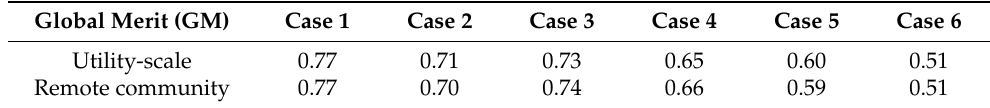
Table 11. Qualitative assessment of wave energy options.